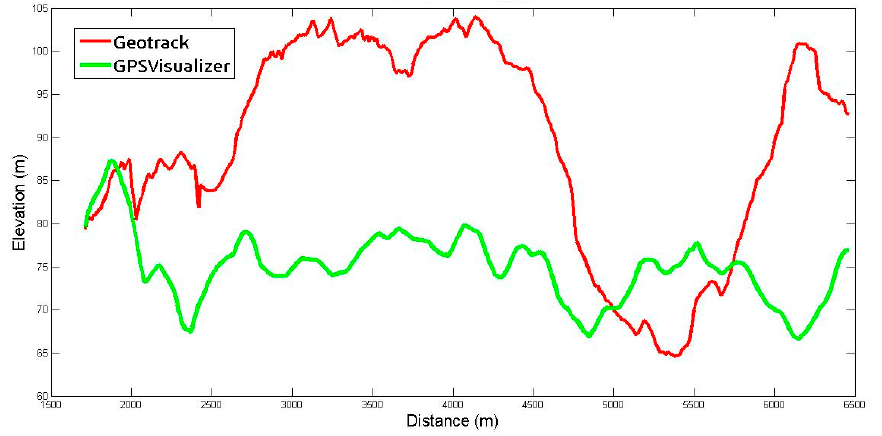
Figure 6. Elevation verification—distance.